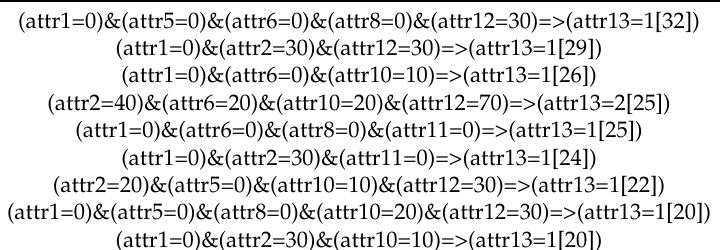
Table 3. Examples of real rules-exhaustive algorithm, Statlog (heart) Data Set [3], Rule statistics: 5352